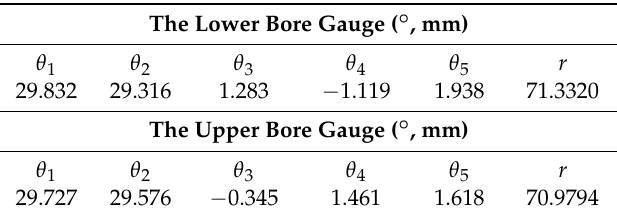
Figure 9. The calibration of the intrinsic parameters. Table 1. The intrinsic